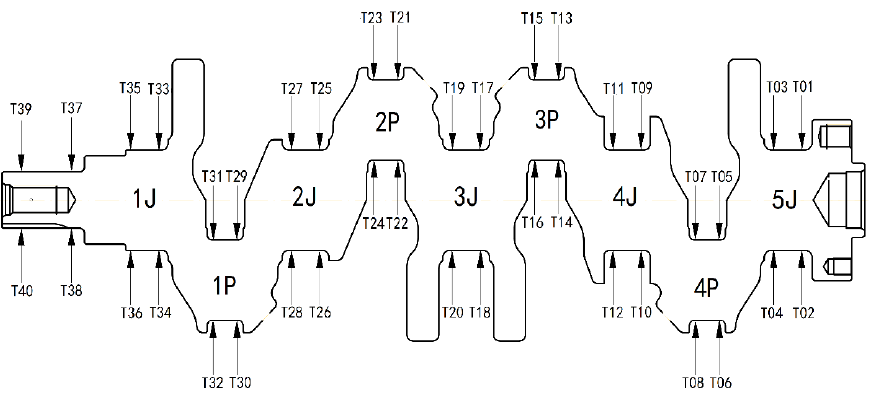
Figure 3. LVDT sensors arrangement of crankshaft.